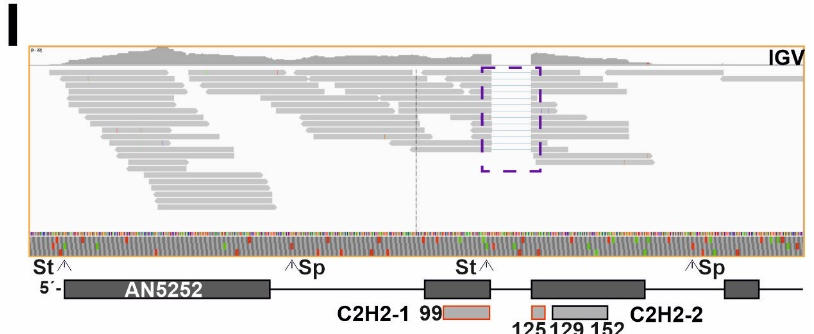
Figure 2. Comparison of annotation of genes potentially encoding TFs and RNA-seq data. ( A ) Pie chart showing the approx- imate number and percentage of TF-coding genes correctly annotated according to RNA-seq data (green), the fraction of those that should be less or more extensively re-annotated (red) and the fraction of those that could not be assessed (mostly due to their very low or null expression levels) (yellow). Approximately 30.6% of the TF-coding genes would need some re-annotation. ( B ) Null expression levels of AN3391 , predicted to encode a C2H2- plus a Zn2Cys6-type dual-specificity TF, in comparison to those of AN3390 , encoding a putative pectinesterase, as an example of genes in which the annotation could not be assessed. Data from our RNA-seq experiments (visualized with IGV; [29–31]) and those provided by the FungiDB database were analyzed [27]. ( C ) Expression levels of AN2290/steA as an example of a gene correctly annotated. RNA-seq experiments retrieved from the FungiDB database corresponded to complete and minimal media [27]; carbon starvation and a null clrB mutant [26]; and null mtfA or null veA backgrounds [28]. ( D ) Alternative splicing event, represented by the case of AN1569 . Annotation of the coding region is correct but there are intron-retention (IR) events in both predicted introns (dotted purple squares); furthermore, the non-processed form is the most abundant. Retention of the first intronic sequence leads to a premature stop codon that would generate a peptide containing only the Zn2Cys6 IPD (amplification of the dotted orange square in the bottom panel). The concentration of the full-length form will be, in all probability, very low. ( E , F ) Examples of genes whose coding sequences should be re-annotated in 5 ′ ( AN11098 in panel E ) and 3 ′ ( AN2782 in panel F ) ends. The dotted orange squares indicate the regions amplified in bottom panels while the dotted purple squares indicate an intron retention event ( E ) or the absence of an intron ( F ). The non-processed form of the fifth predicted intron of AN11098 adds, compared to the annotated sequence, 17 extra codons between those coding for amino acids D399 and G400, but without modifying the reading frame. ( G – I ) Examples of genes which would need major re-annotation of their coding sequences. The first predicted intron of AN1812/jlbA ( G ) is not present, generating a long 5 ′ -UTR region. The probable start codon will be that for Met175, retaining only the sequence encoding the bZIP domain. The predicted two introns of AN9221 ( H ) are probably absent, generating two coding sequences, alnG and alnR of the asperlin cluster (see main text). The coding region of alnR , a TF of the asperlin metabolic cluster, will probably begin with the codon for Met246 (FungiDB coordinates). The first predicted intron of AN5252 (or An9240 ) ( I ) is not present, possibly leading to two coding sequences (those covering M1-G90 plus 9 codons and M127-D168 plus 20 codons). The first C2H2 domain (dark grey square bold in red) would be lost, while the second coding region would include the second C2H2 IPD. St: start codon. pSt: predicted start codon. Sp: stop codon. pSp: predicted stop codon. aSp: alternative stop codon. RF: reading frame. See also Table S5.